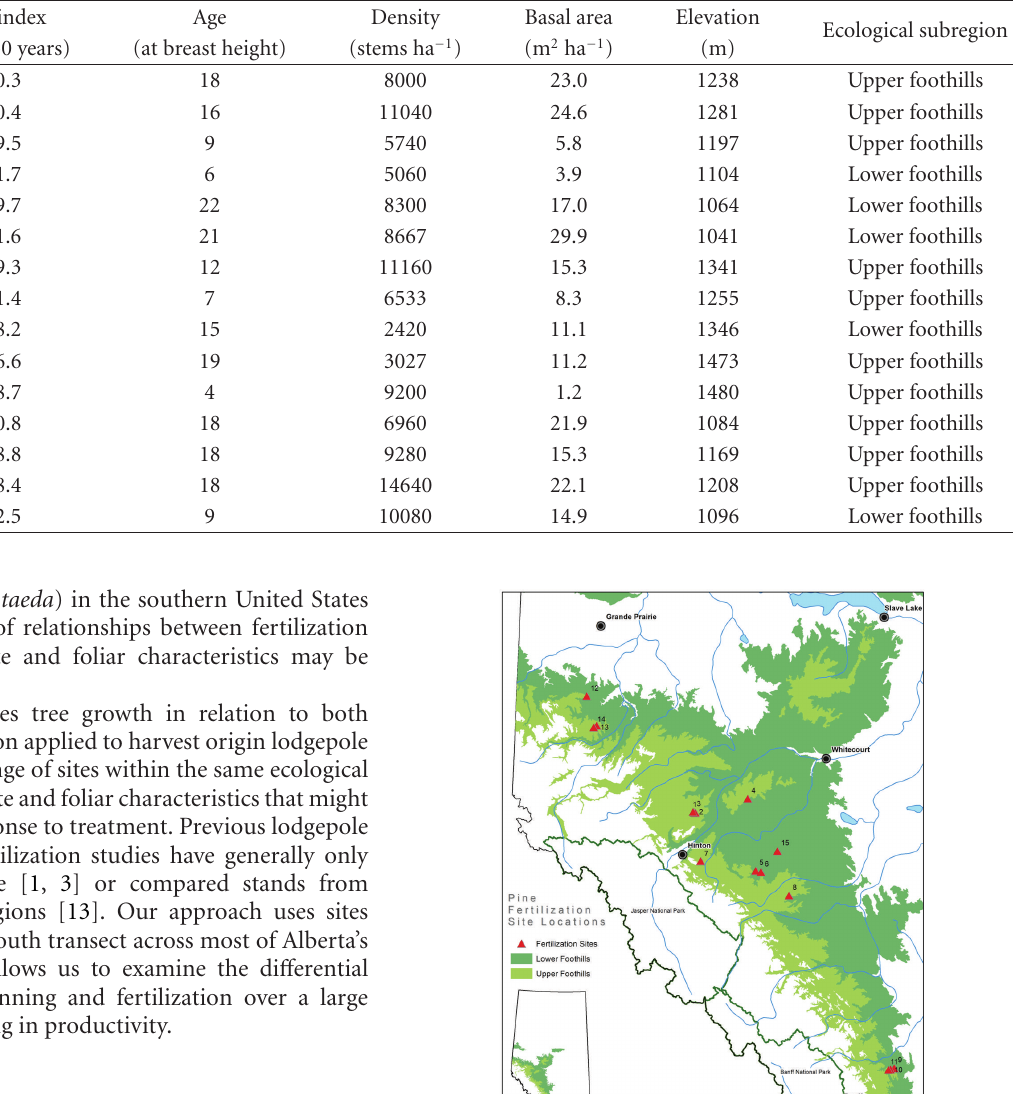
Table 1: Site properties for each of the 15 stands.